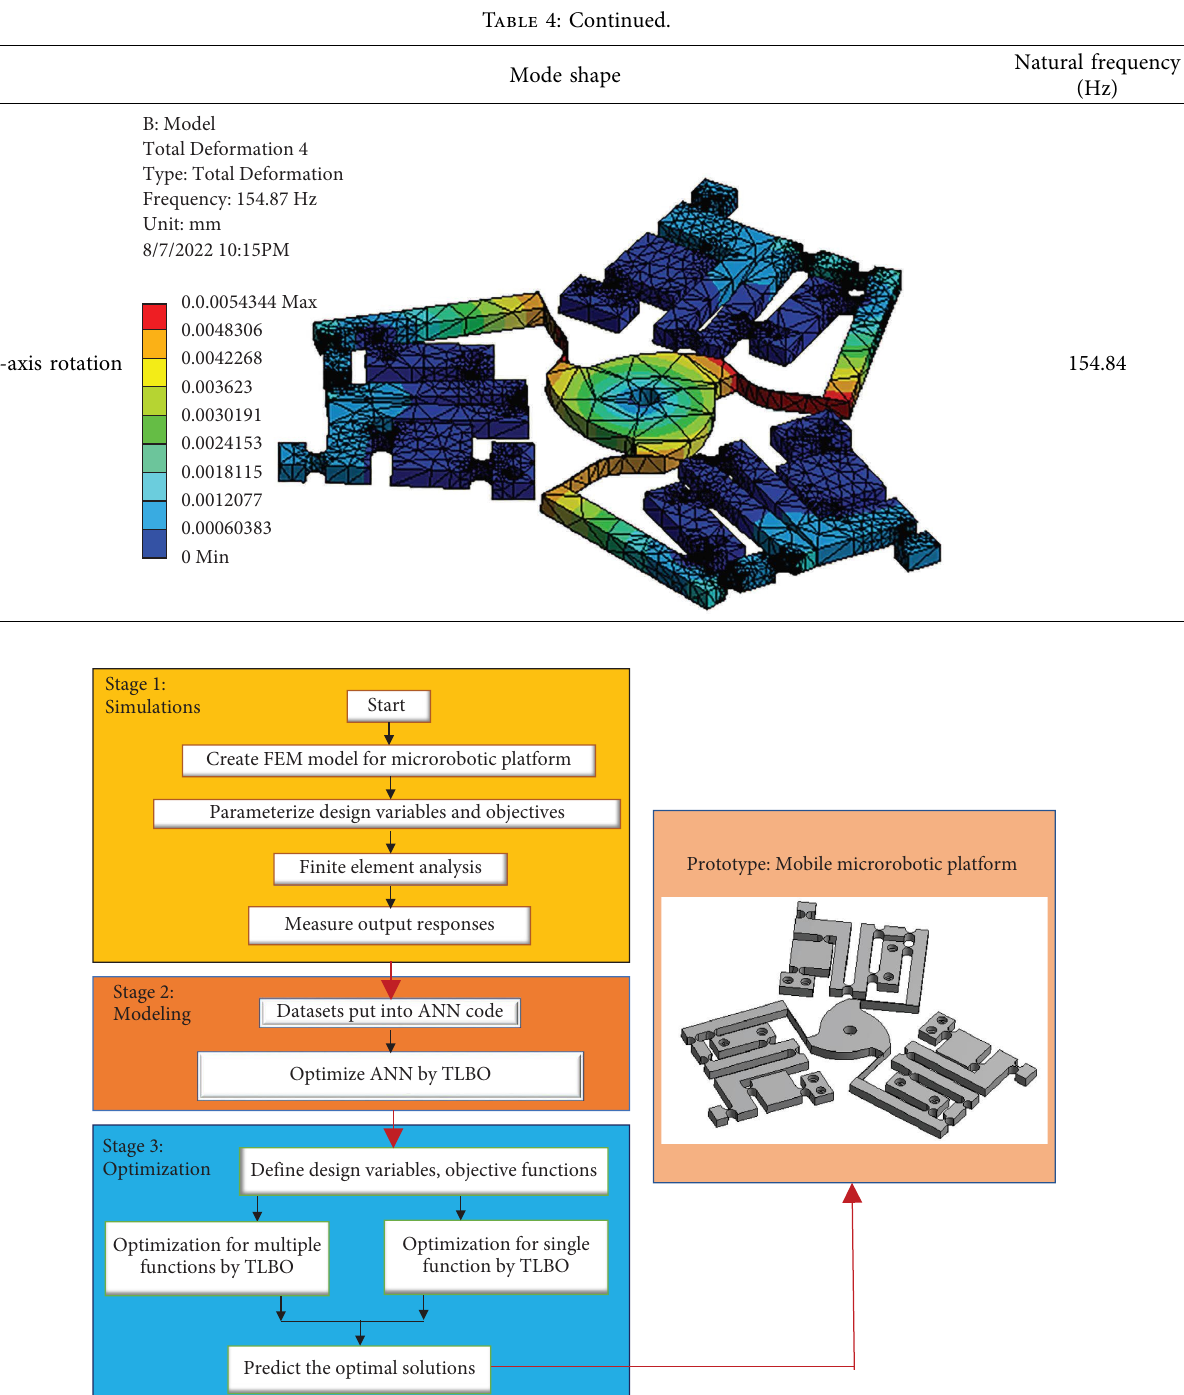
Figure 9: Flowchart of modeling and optimizing method for microrobotic